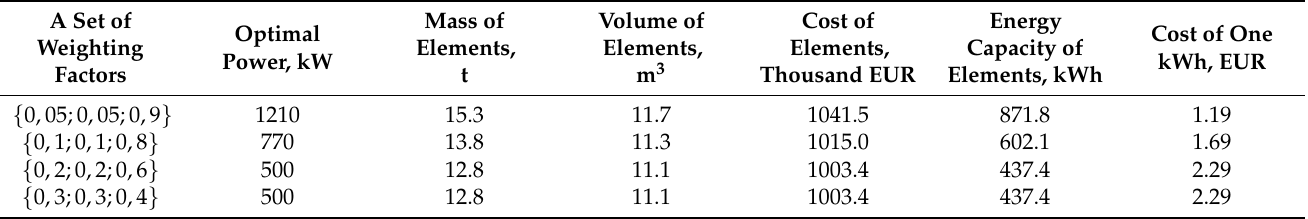
Table 8. Results of calculations of ES parameters with hybridization of LFP elements and supercapacitors.